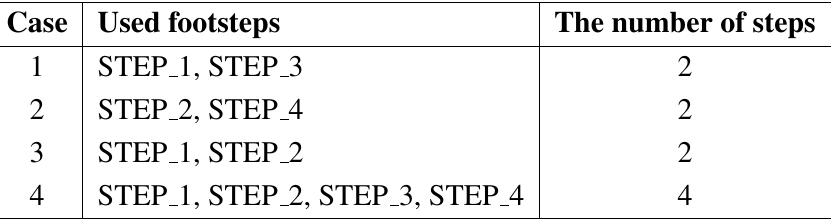
Table 3. Stepping feature sets in terms of used footsteps.